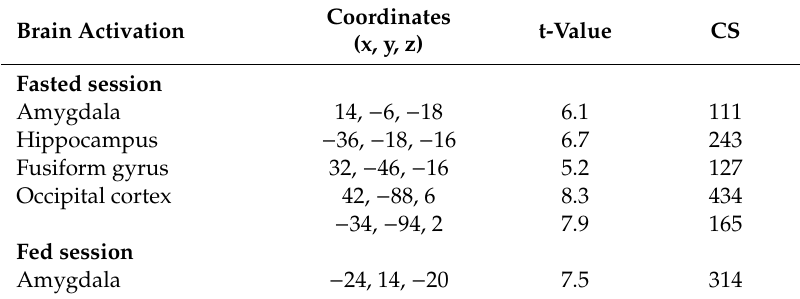
Table 3. Brain regions showing significant activation in response to the sight of high-calorie vs low-calorie foods in the fasted and fed